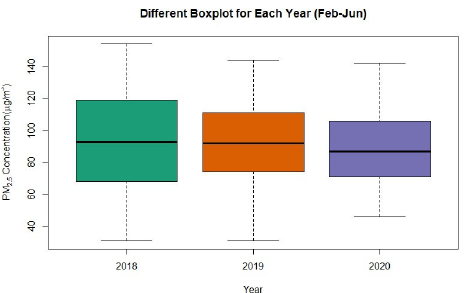
Fig. 2. Histograms of PM 2.5 concentrations in the periods without and during the period with COVID-19